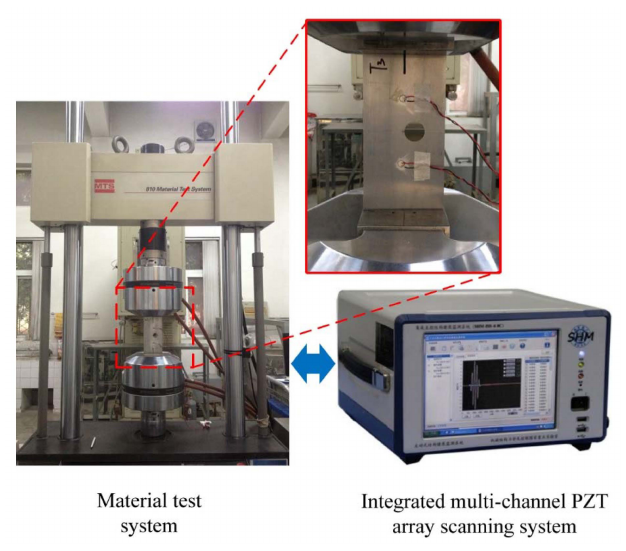
Figure 7. The experimental setup.